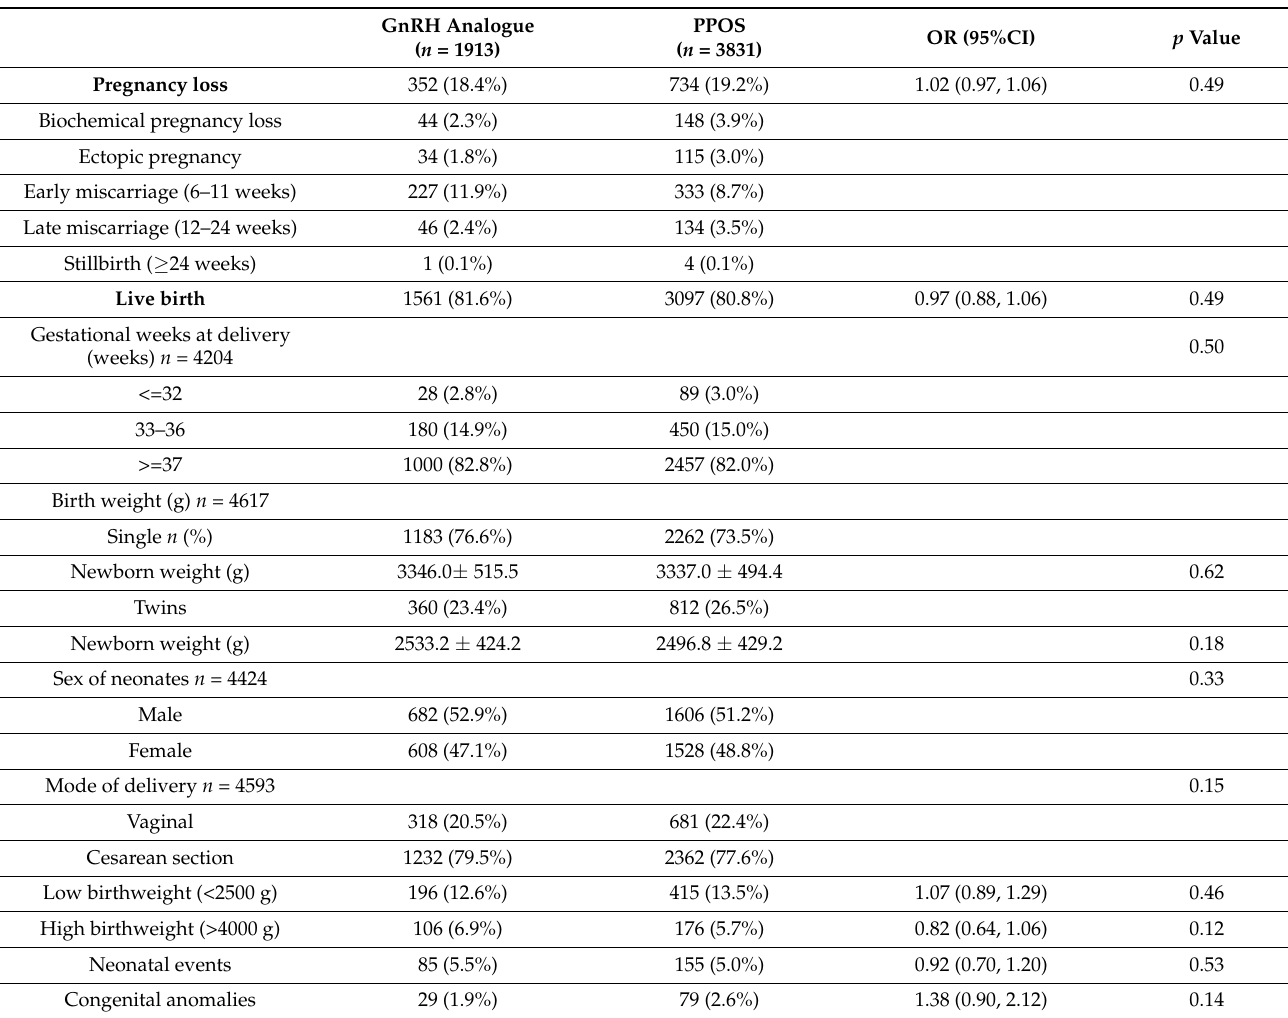
Table 2. Pregnancy outcomes of positive hCG women between GnRH analogue and PPOS groups using the matched